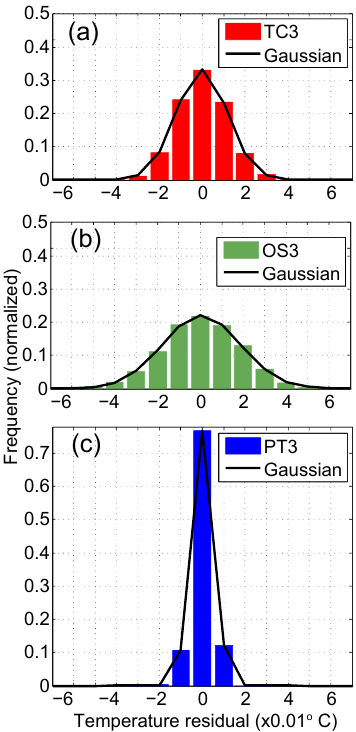
Figure 4. Examples of the characteristic temperature residuals from their mean values over periods of several hours during calibra- tion runs for (a) TC3 at − 40 ◦ C, (b) OS3 at − 0 ◦ C and (c) PT3 at − 30 ◦ C. Slow trends in the data have been removed, and the measurements are smoothed with a 5s fixed median window. The standard deviations of Gaussian fits to the data are (a) 0.012 ◦ C, (b) 0.018 ◦ C and (c) 0.004 ◦ C. See Supplement for distributions of other